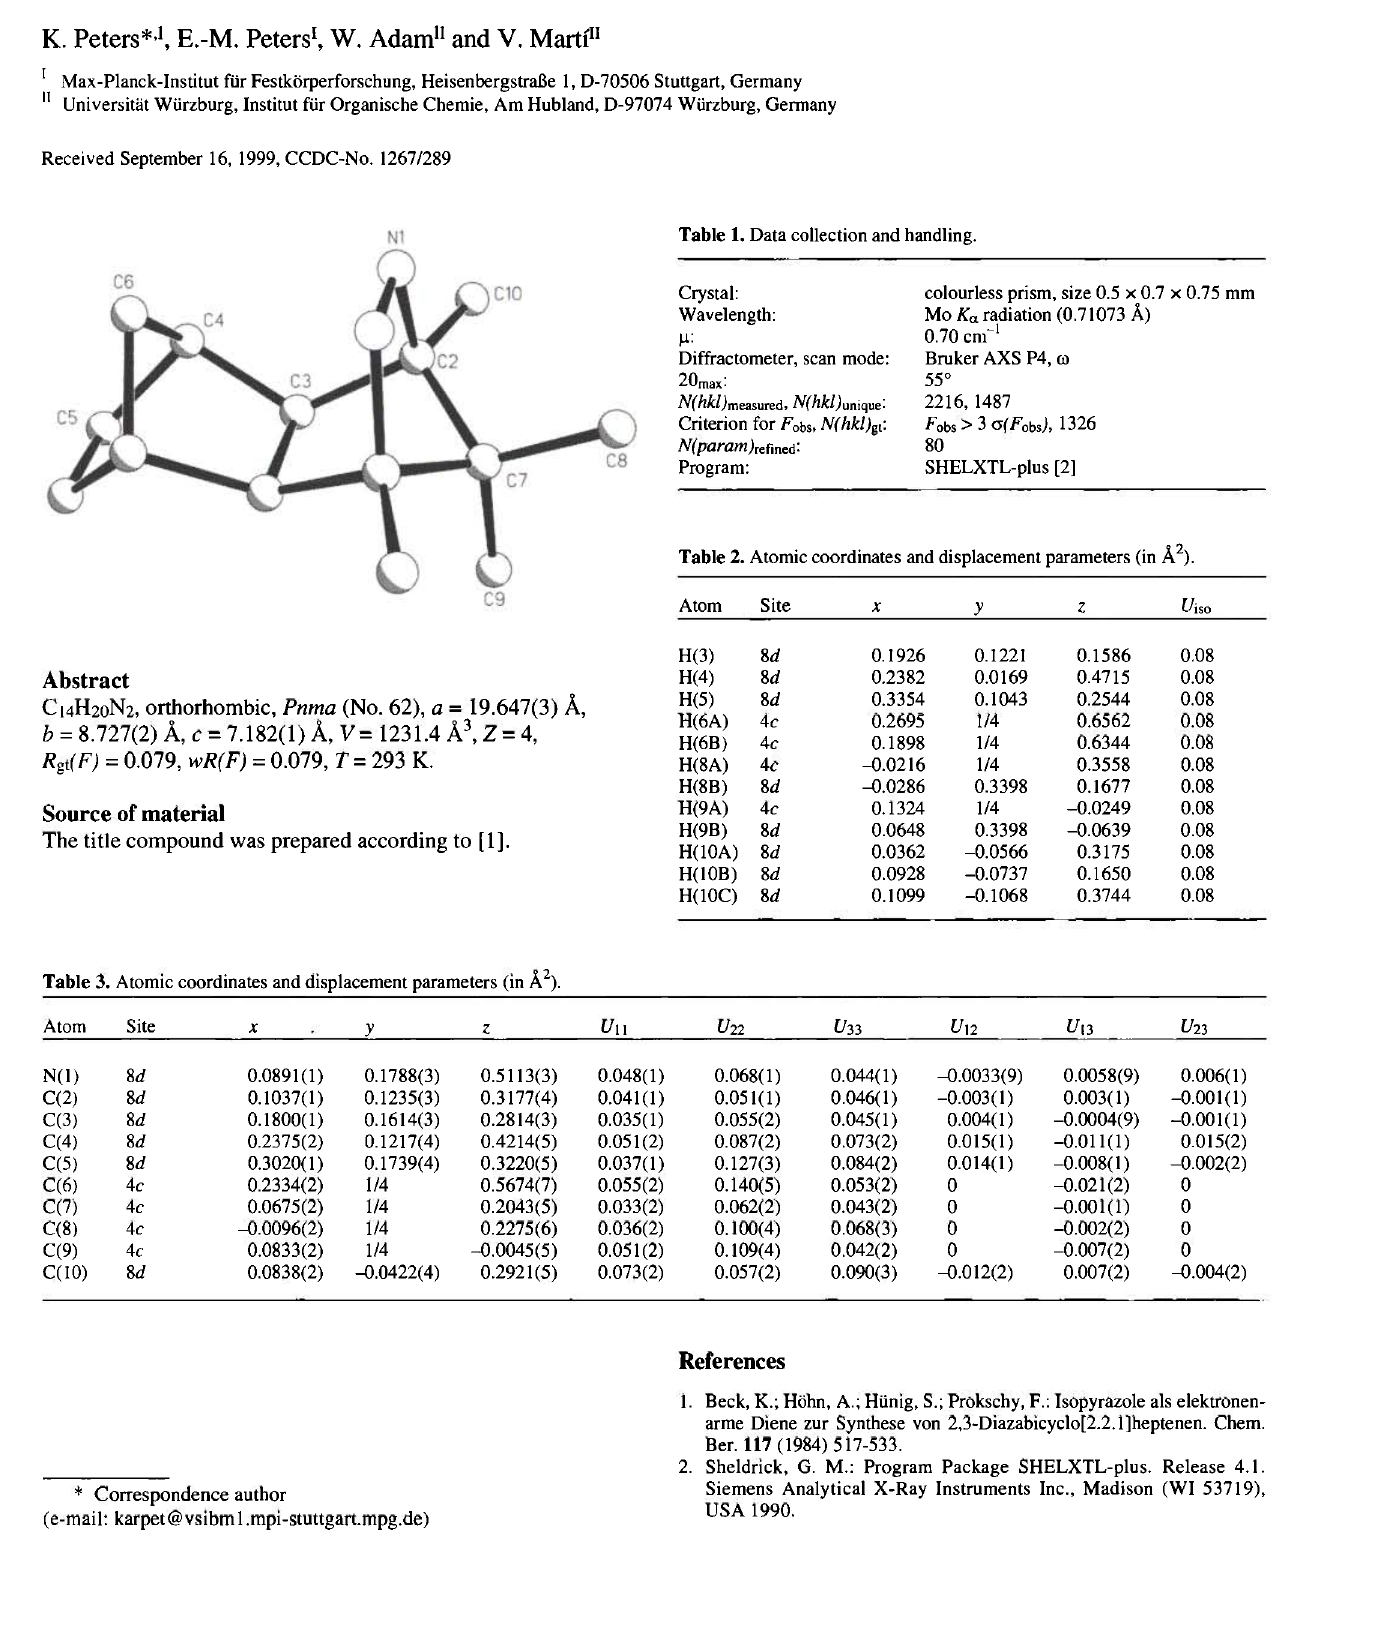
Table 2. Atomic coordinates and displacement parameters (in Ä 2